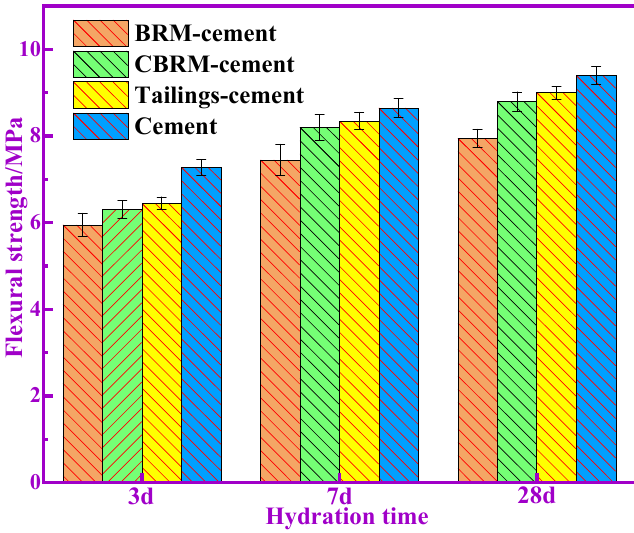
Figure 3. Flexural strength of cementitious materials.